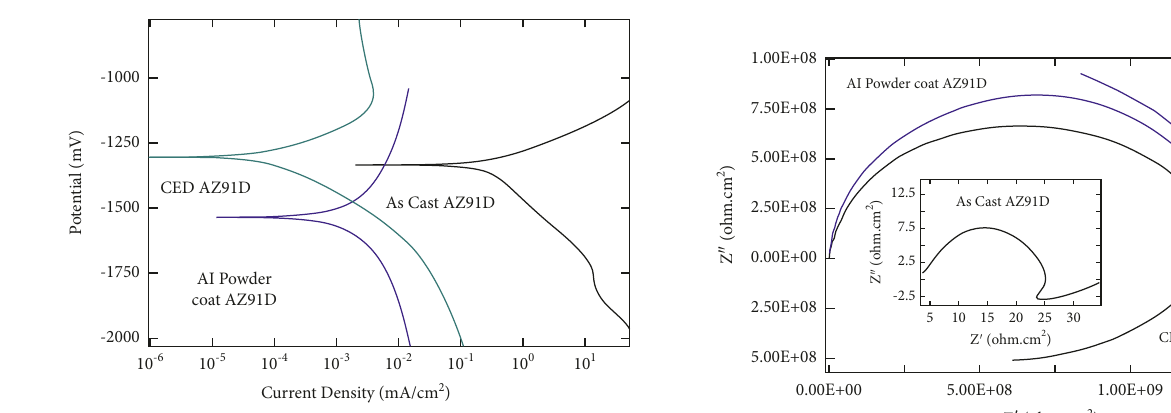
Figure 14: Variation of current density with applied voltage for AZ91 samples. Figure 15: Impedance curves for AZ91D alloy samples.